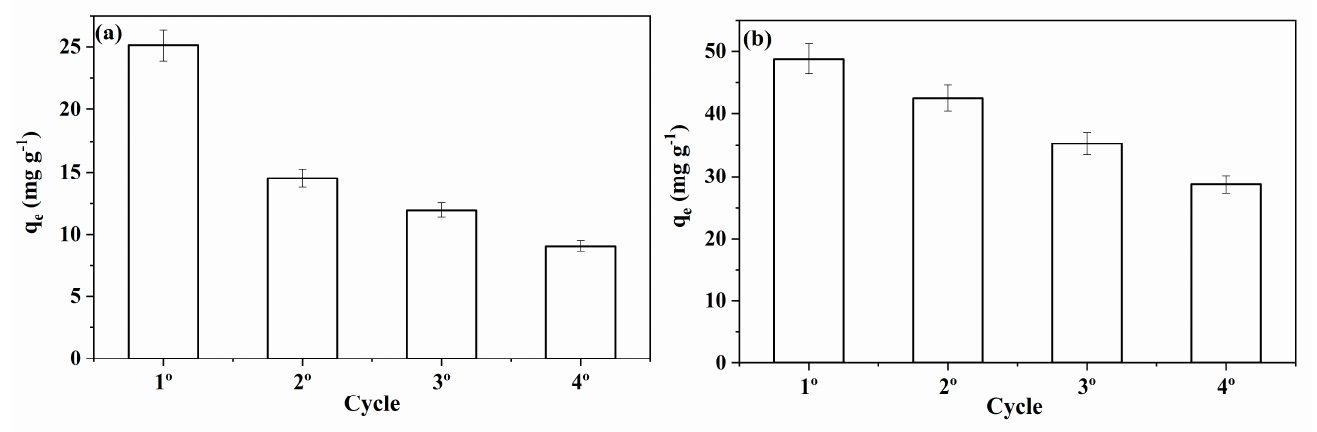
Figure 9. Reuse cycles of ( a ) MAC1105 and ( b ) MAC111.